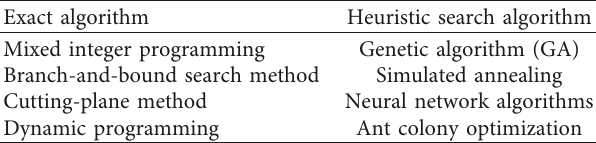
Table 2: Commonly used algorithms for solving TSP. Exact